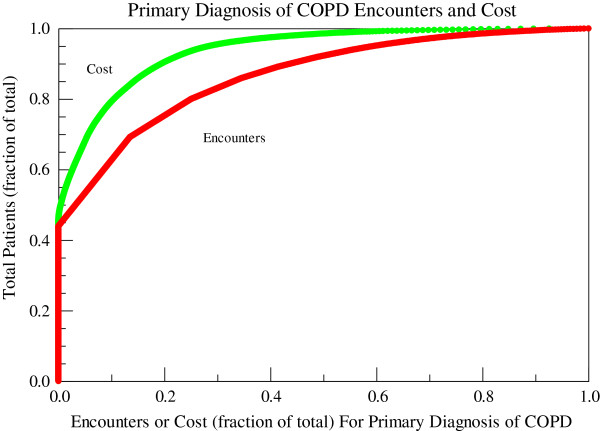
Encounters and costs for a primary diagnosis of COPD at the cincinnati VAMC in FY08. Costs are represented by the green line and encounters (outpatient visits, emergency department visits, and hospitalizations) by the red line. FY: fiscal year; COPD: chronic obstructive pulmonary disease.